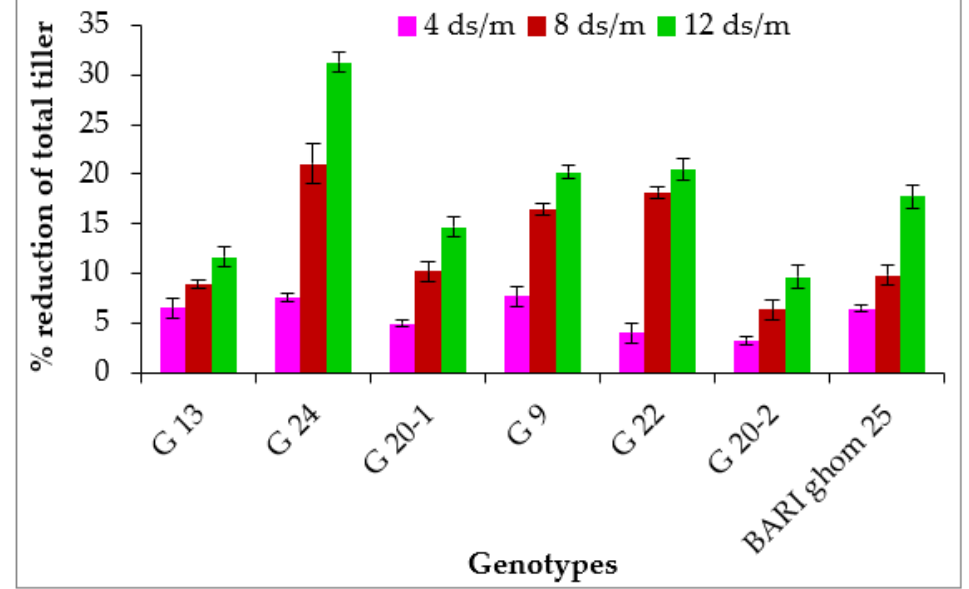
Figure 2. Reduction (%) of total tillers of wheat genotypes under various salinity levels. The vertical bar indicates average of five independent replicates ( n = 5). Error bars represent standard error.